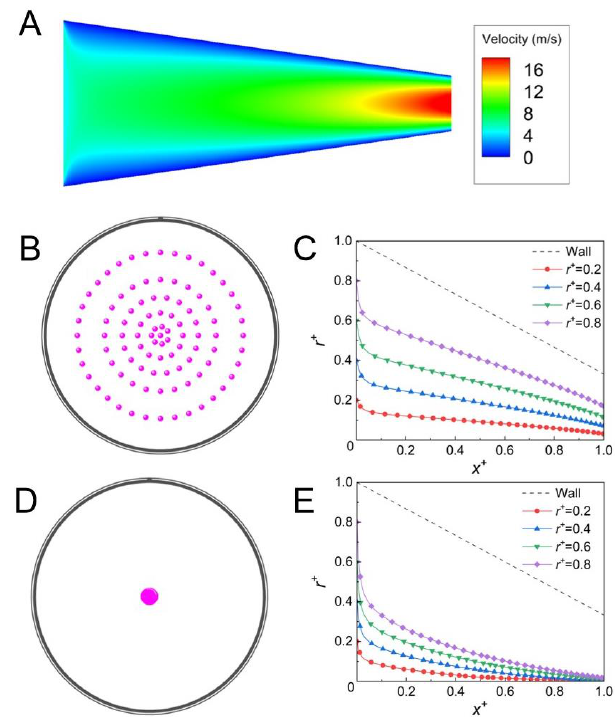
Figure 6. ( A ) Contour of the velocity in the x direction in the converging channel; ( B ) particle distribution at outlet of the converging channel without the reverse external force; ( C ) particle trajectories in the converging channel without the reverse external force (particles were released from r + = 0.2, 0.4, 0.6, and 0.8, respectively, u = 4.5 m/s, d p = 1 μm, ρ p = 1550 kg/m 3 ); ( D ) particle distribution at the outlet of the converging channel at the reverse external force of 5 × 10 − 10 N; ( E ) particle trajectories in the converging channel at the reverse external force of 5 × 10 − 10 N (particles were released from r + = 0.2, 0.4, 0.6, and 0.8, respectively; u = 4.5 m/s, d p = 1 μm, ρ p = 1550 kg/m 3 ).